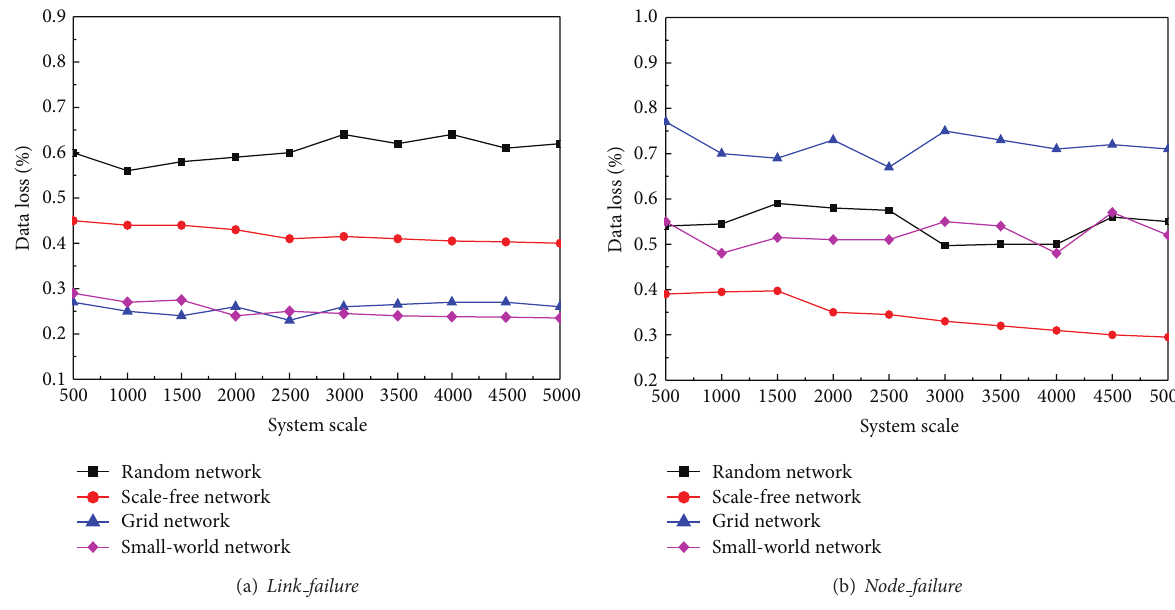
Figure 6: Data loss from network recovery in different network